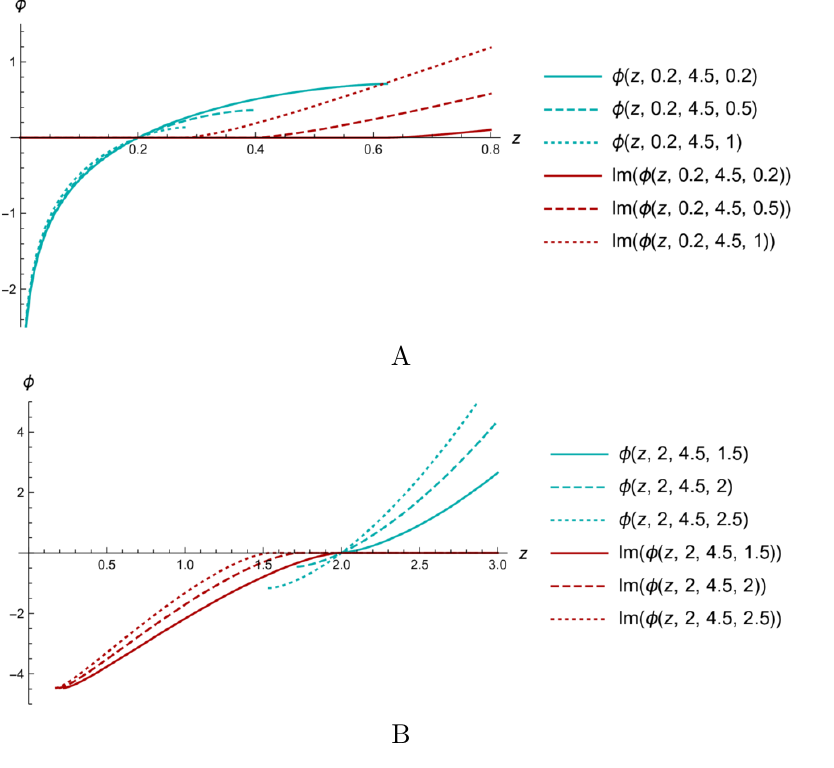
Figure 4 . Scalar (cid:12)eld (cid:30) ( z; z h ; (cid:23); c ) and its imaginary part for (cid:23) = 4 : 5, di(cid:11)erent positive c , z h = 0 : 2 (A) and z h = 2 (B).